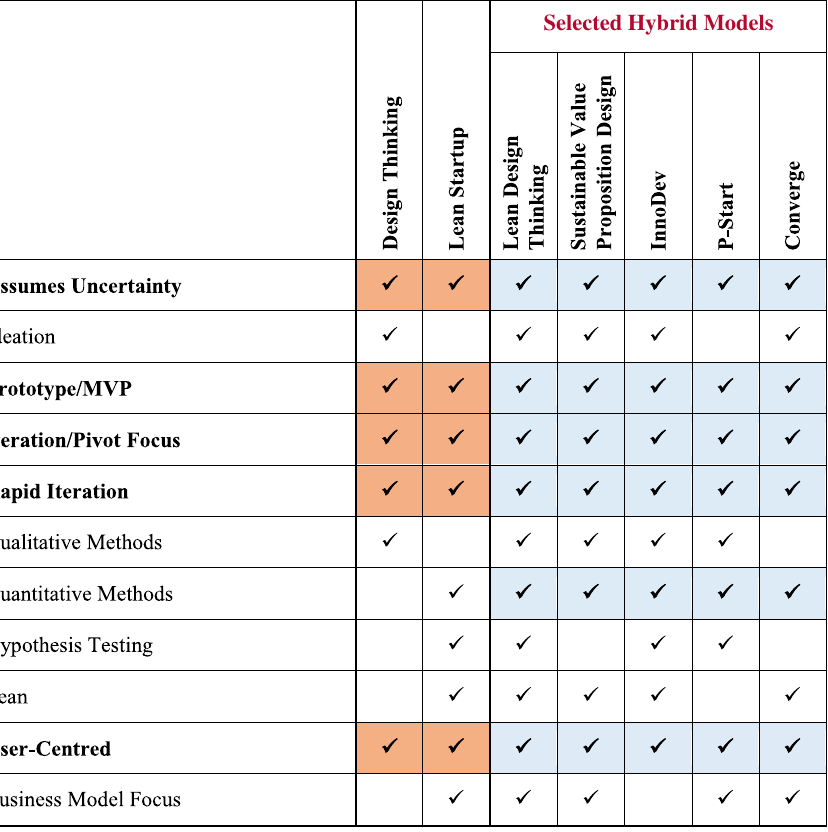
Table 4 Comparison of features; DT, LS, and other identified models